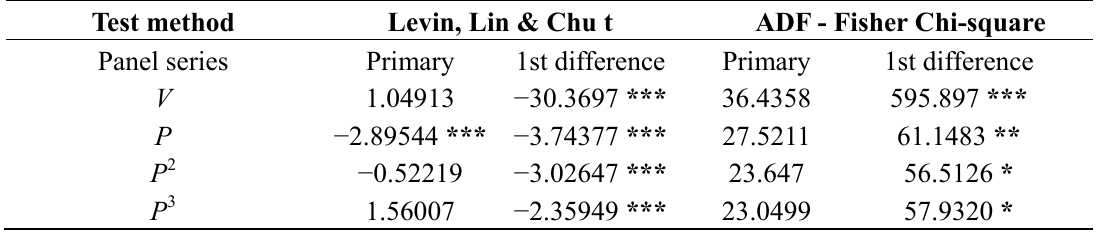
Table 2. Test statistics of the panel unit root test for the variables involved in Equation